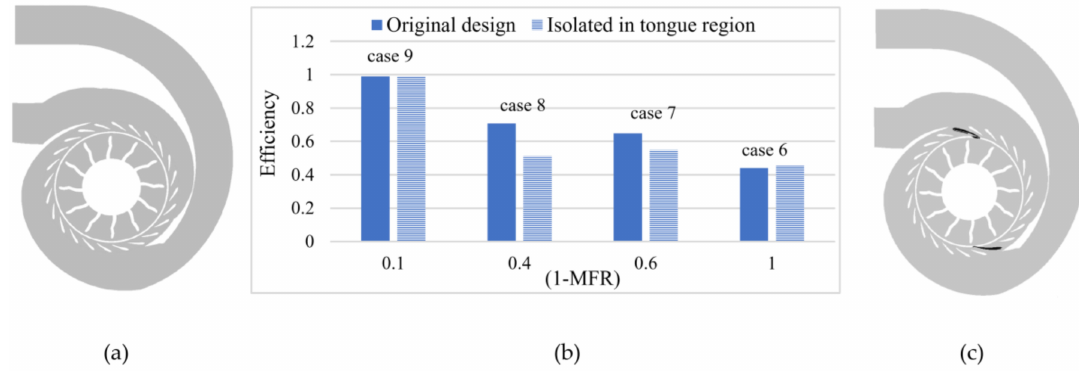
Figure 7. ( a ) Original geometry; ( b ) efficiency drop with increasing the pressure inequality of two limbs ( c ) separated in tongue region (A and B).